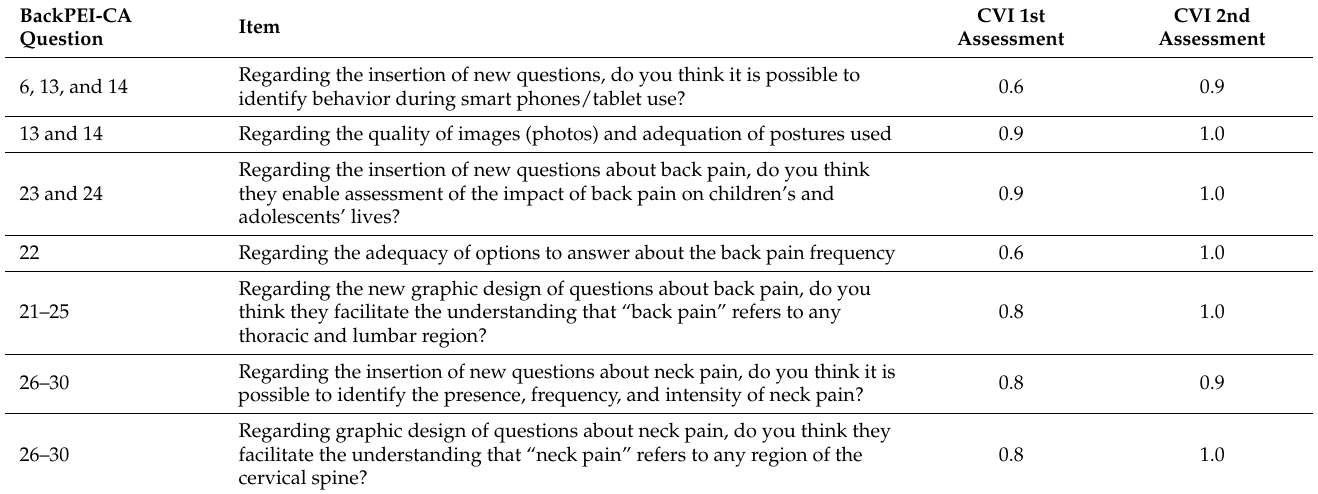
Table 3. Content validity aspects assessed by experts and the Content Validity Index (CVI) of each assessment.